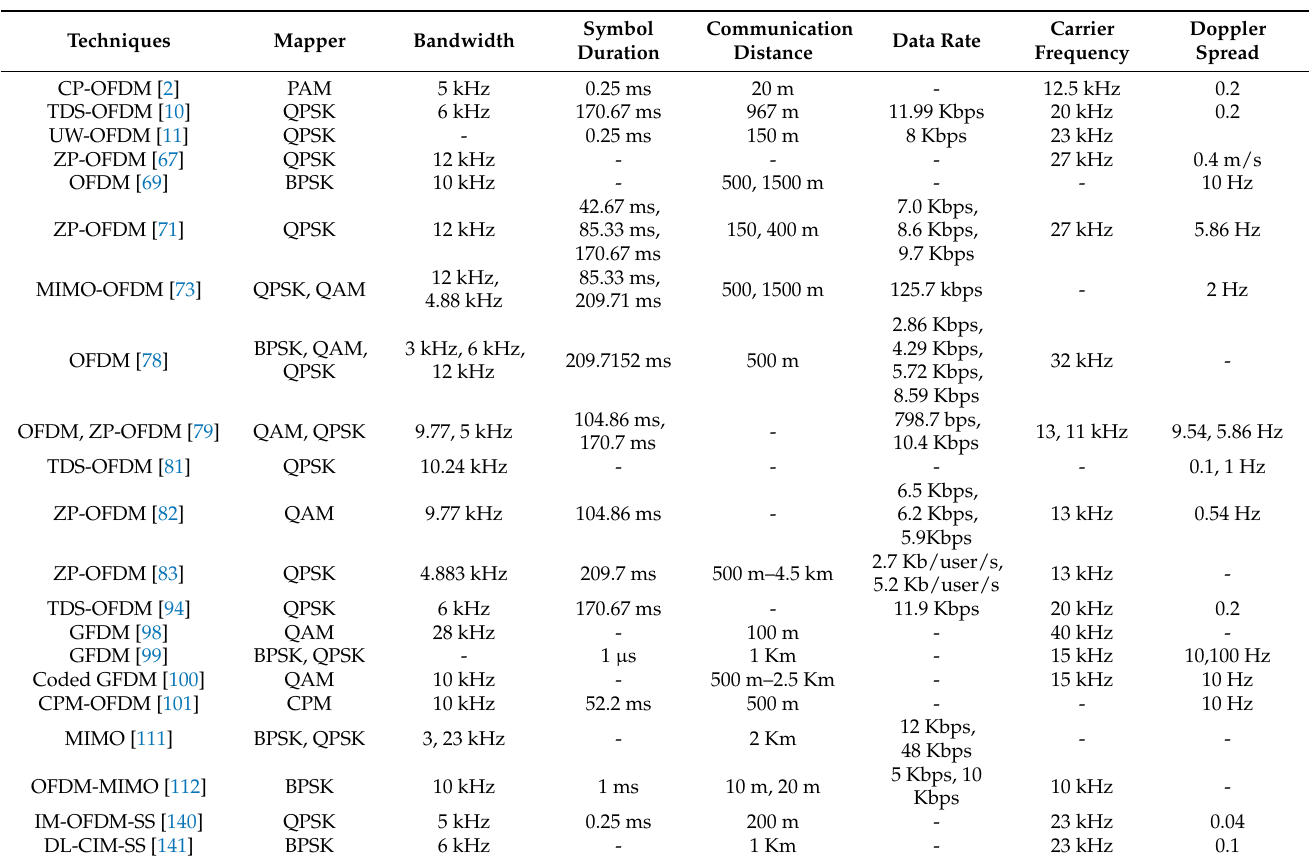
Table 5. Some notable key contributions of physical layer UWAC